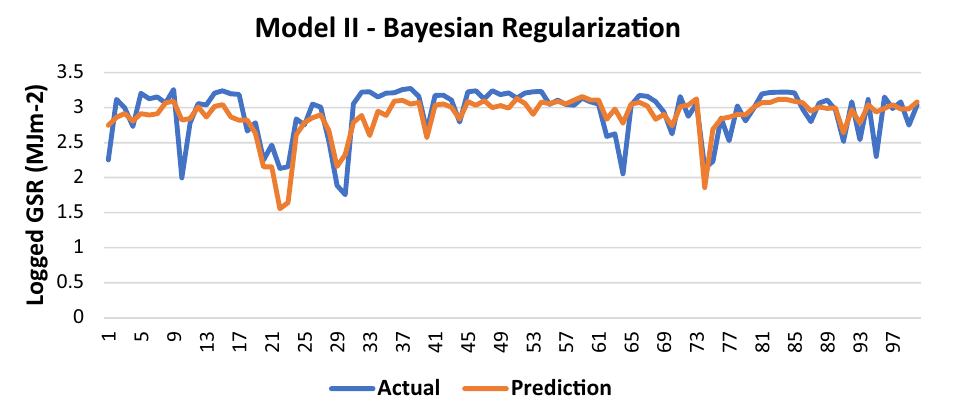
Figure 8. Graph of Actual and Predicted GSR (Model II—BR).